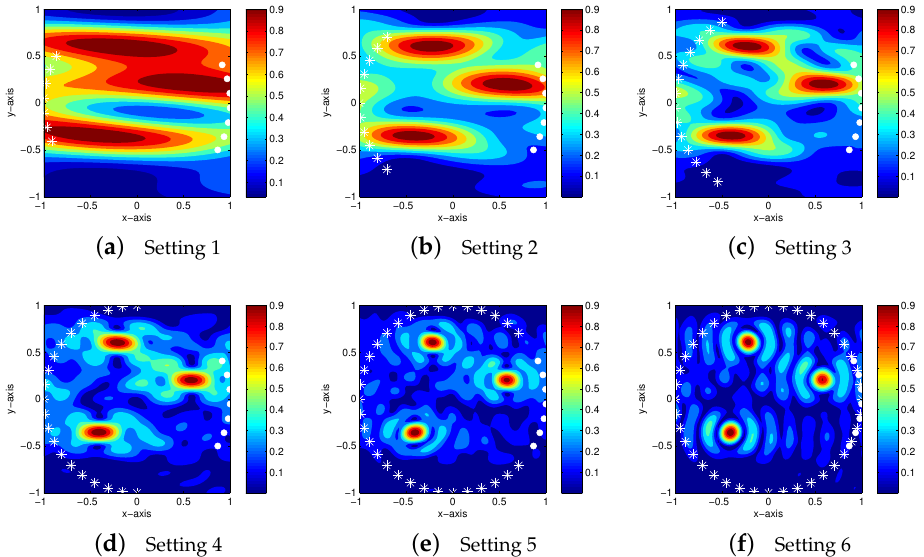
Figure 2. Maps of f SM ( x ) . White colored marks o and (cid:63) denote the incident and observation directions, respectively.